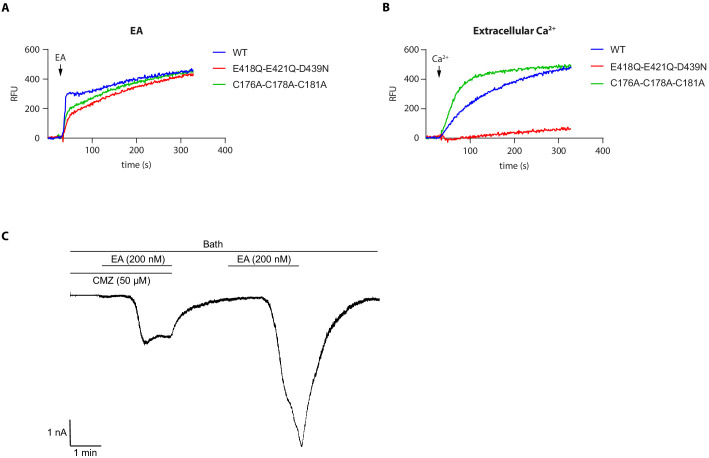
Functional characterization of various human TRPC5 (hTRPC5) mutants related to ion-binding sites.(A–B) Representative intracellular calcium signal of AD293 cells transfected with wild-type or hTRPC5 mutant evoked by 256 nM EA (A) or 14 mM extracellular calcium (B), measured by FLIPR calcium assay. (C) Macroscopic currents of hTRPC5 recorded in whole-cell mode in calcium-free condition.